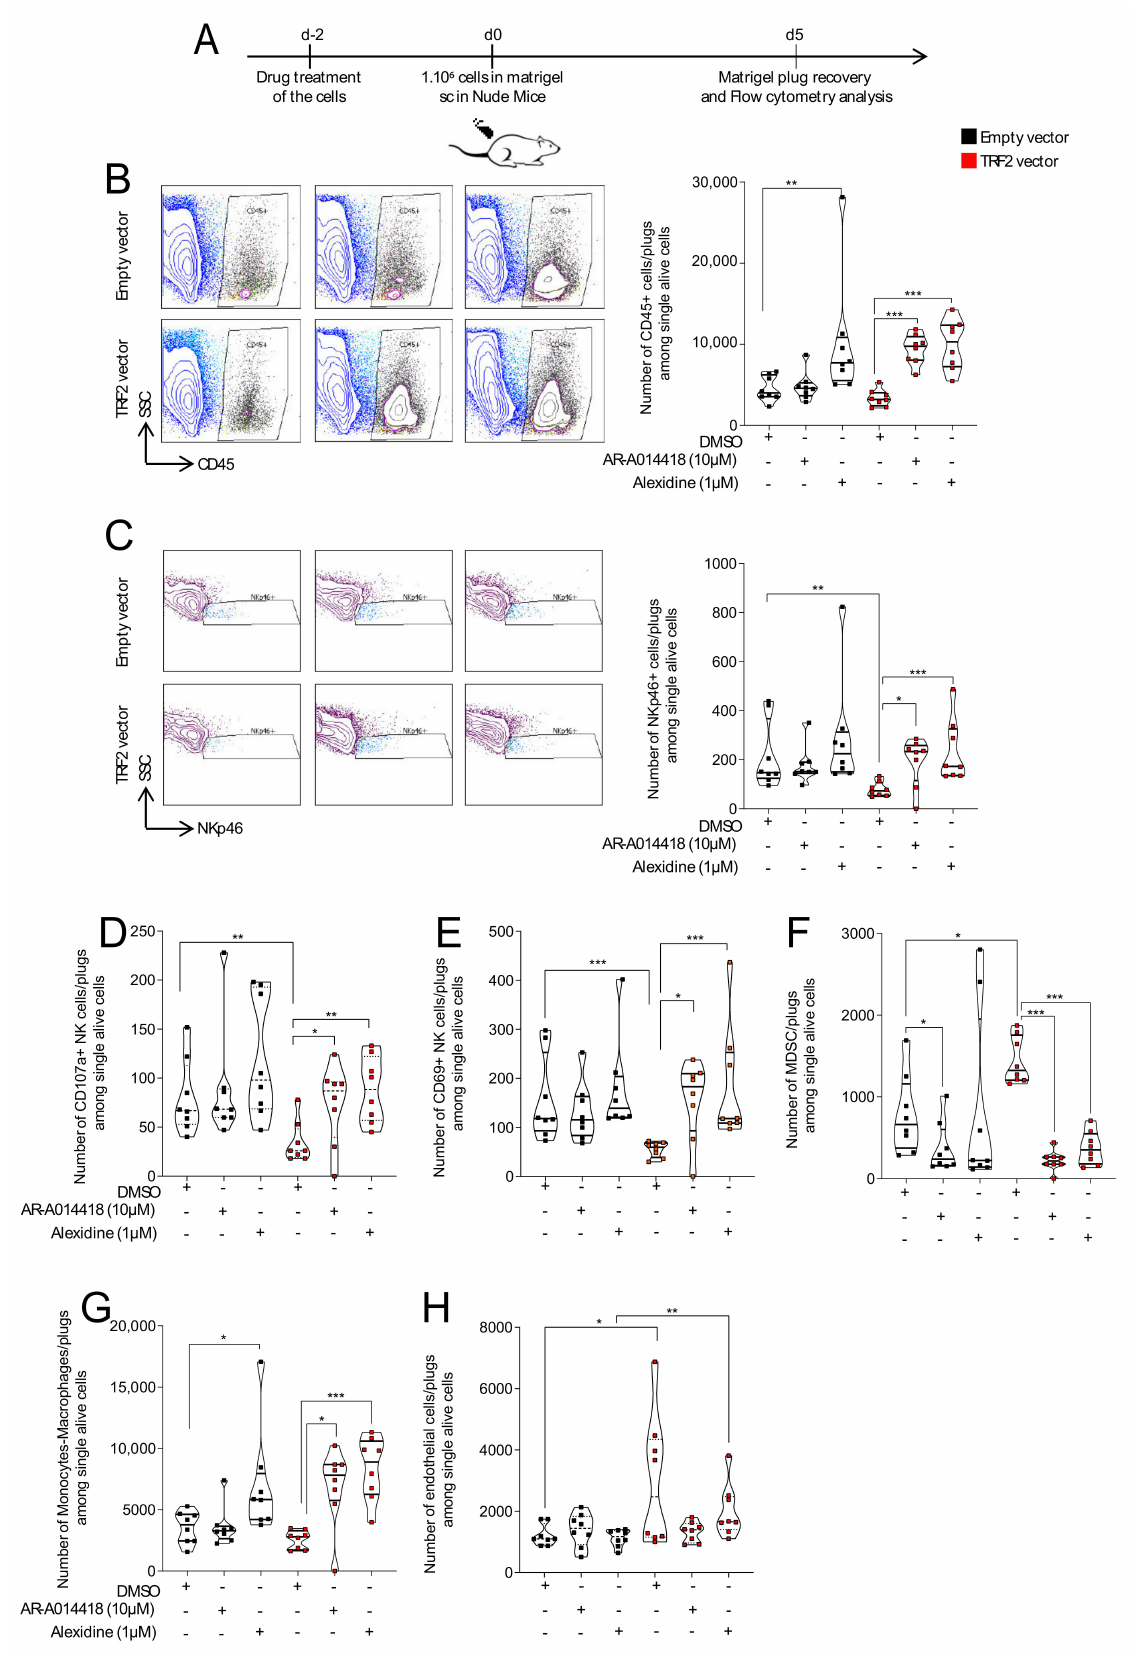
Figure 3. Treatment with alexidine · 2HCl or AR-A014418 reverted the TRF2-mediated immunosuppressive microenvironment and restored immune cell infiltration. ( A ) Schematic representation of the experimental design. BJ-HELTRas cells